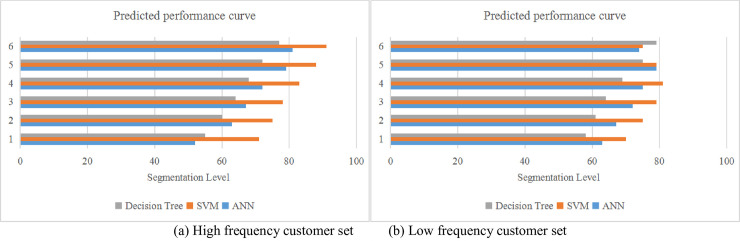
Comparison of prediction performance at different aggregation levels.(a) High frequency customer set. (b) Low frequency customer set.